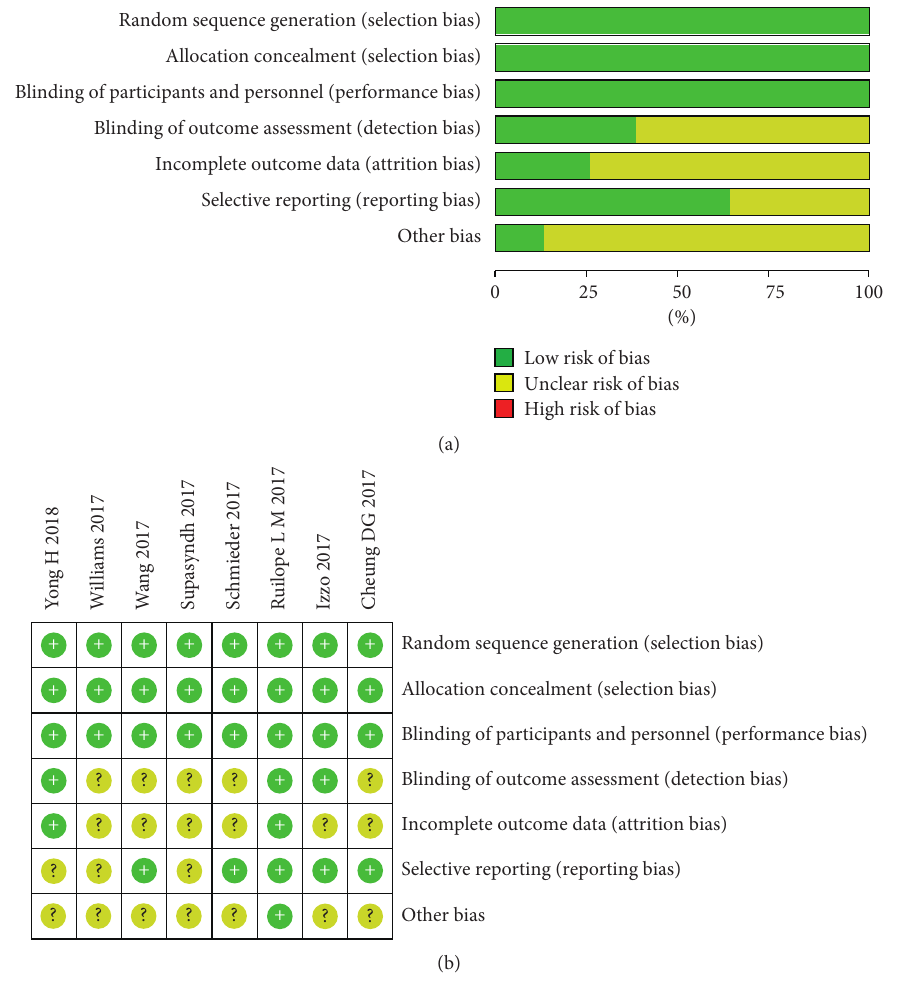
Figure 2: Risk assessment of bias in clinical